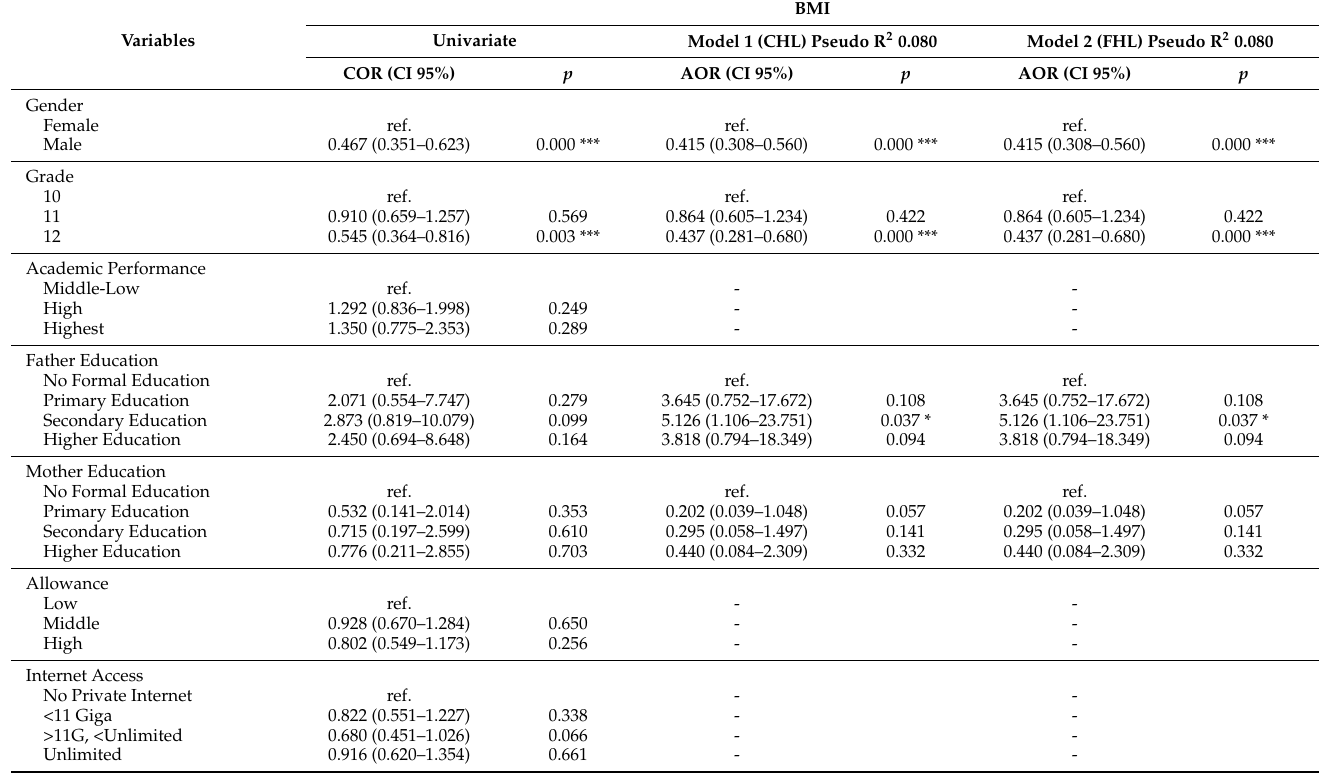
Table 3. Univariate and multivariate logistic regression of BMI with socioeconomic factors in the CHL and FHL